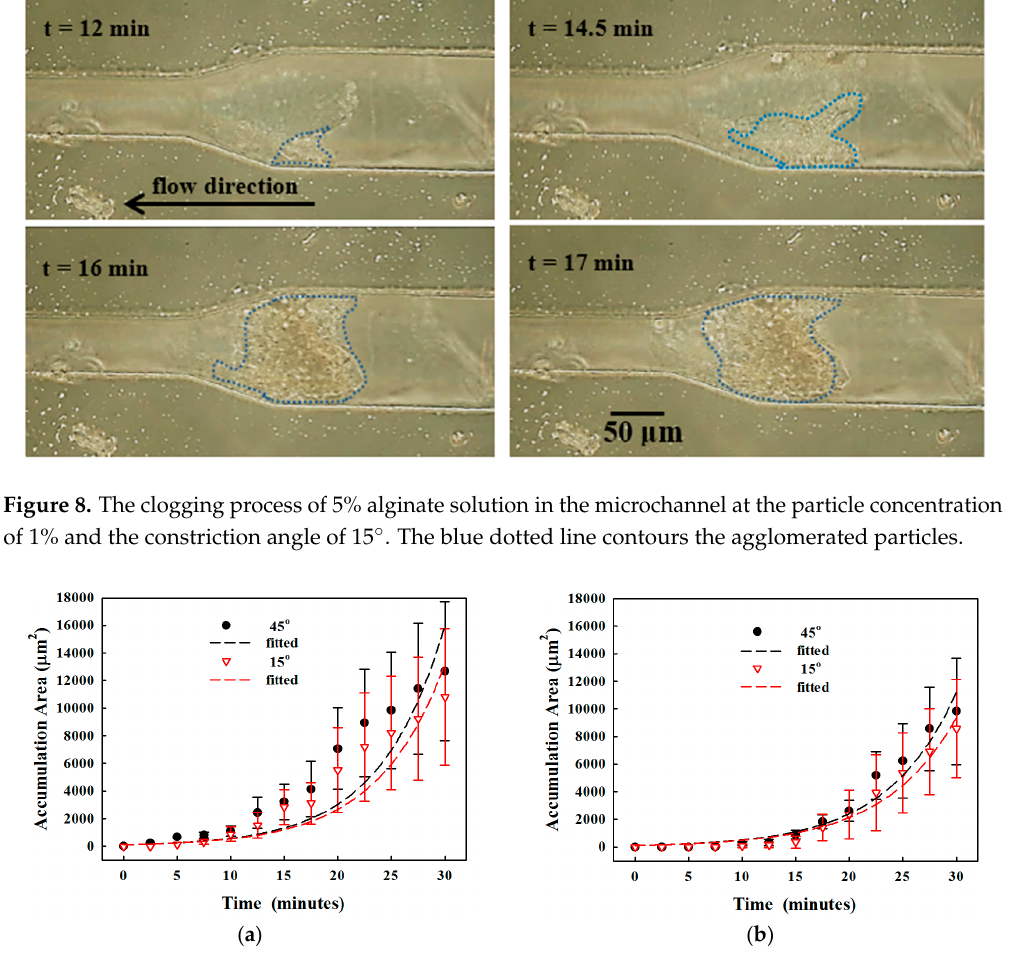
Figure 9. Time-dependent accumulation area of particles in the microchannel at the constriction angle of 15° and 45° with 1% microparticles in ( a ) 3%, and ( b ) 5% alginate solution.